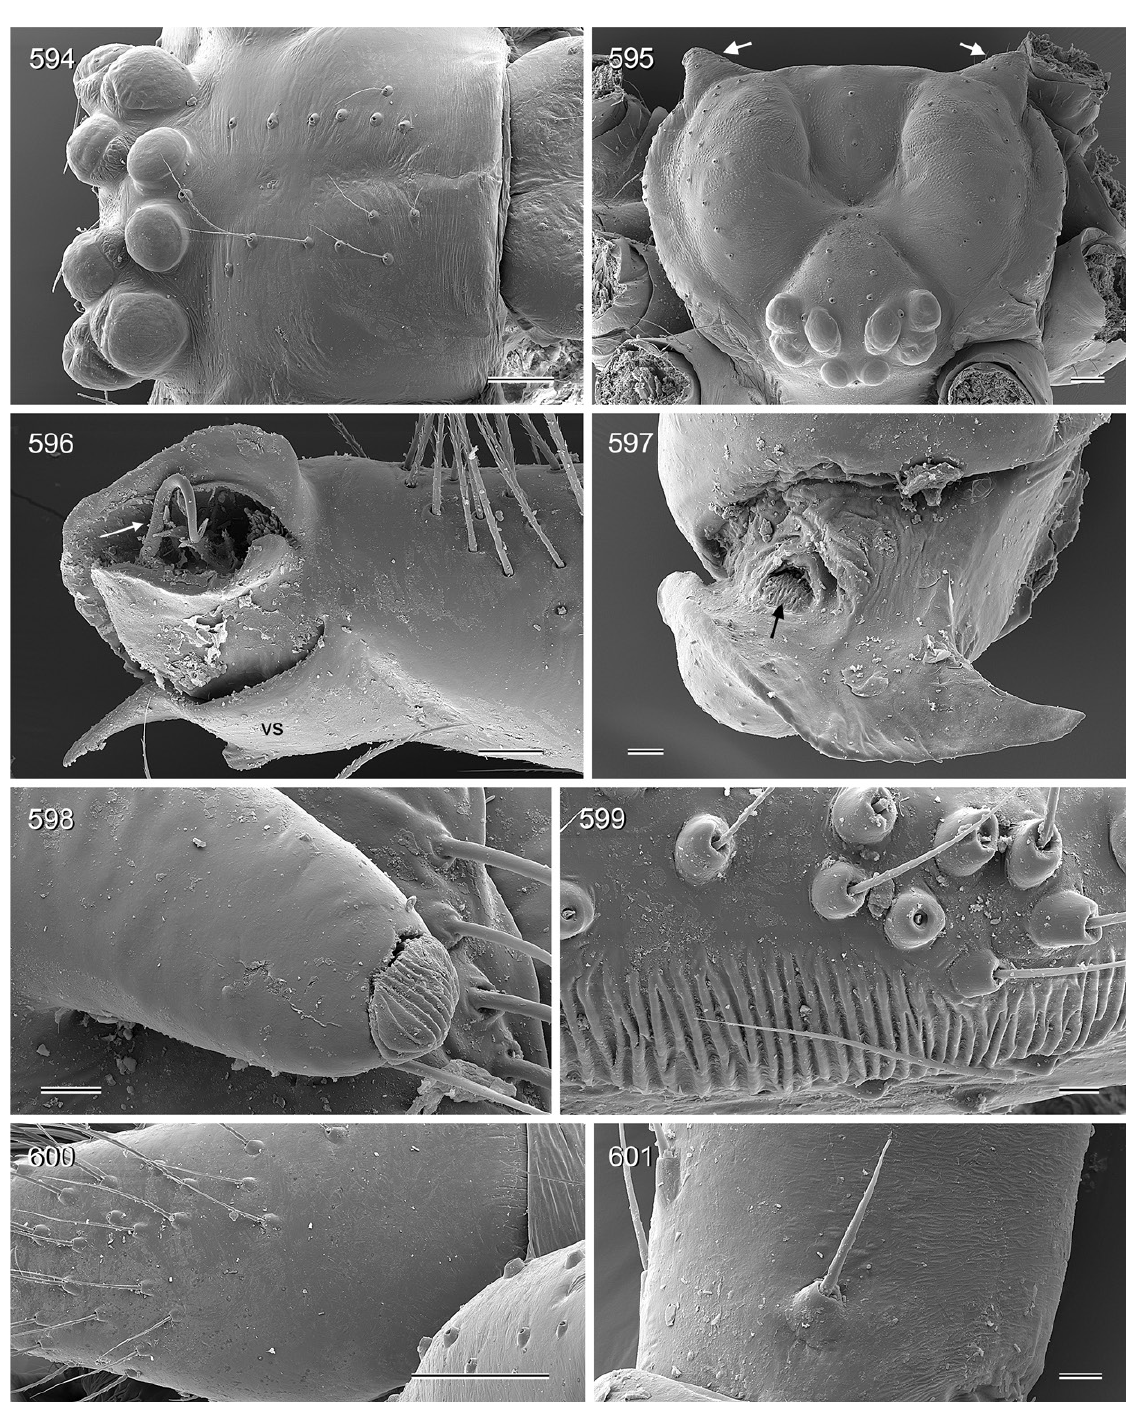
Figs 594–601. Crossopriza semicaudata (O. Pickard-Cambridge, 1876); male and female from Chad, Bardaï (MRAC 132959). 594 . Male ocular area and clypeus. 595 . Female ocular area and carapace; arrows: stridulatory processes. 596 . Left procursus tip, retrolateral view; arrow: hair-like process. 597 . Distal sclerite of right genital bulb, prolateral (slightly distal) view; arrow: sperm duct opening. 598 . Tip of male cheliceral apophysis. 599–600 . Male stridulatory file and corresponding smooth side of female chelicera. 601 . Proximal prolateral hair on female palpal femur. Abbreviation: vs = ventral sclerite. Scale bars: 594–595, 600 = 100 µm; 596 = 30 µm; 597 = 20 µm; 598–599, 601 = 10